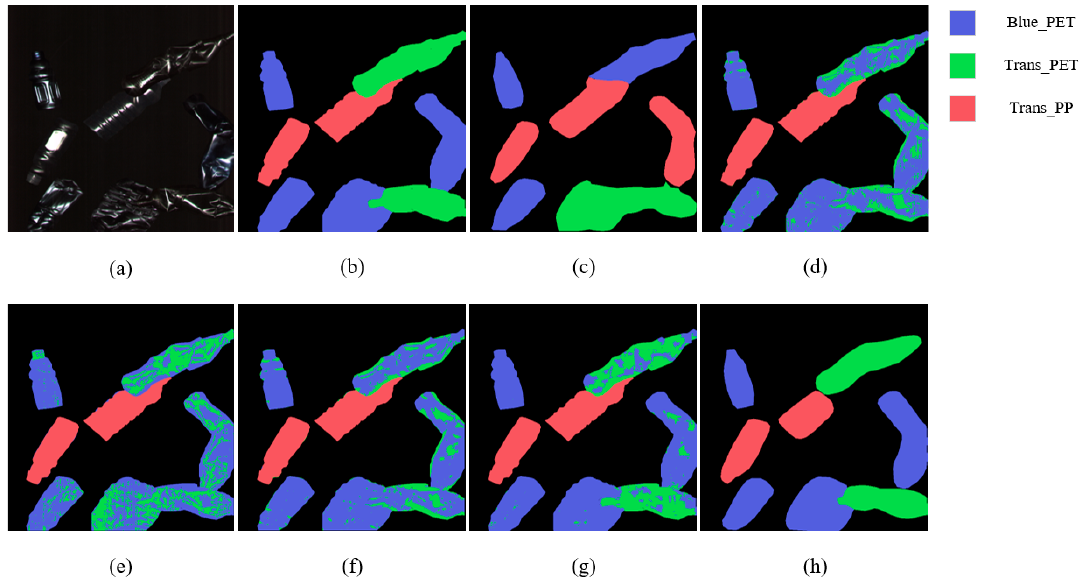
Figure 9. Classification maps for cluttered bottles. ( a ) RGB image. ( b ) Ground truth. ( c – h ) Predicted classification maps for SOLOv1, ContextualNet, 3D-CNN, SSRN, HybridSN, and proposed RHFF- SOLOv1, respectively.